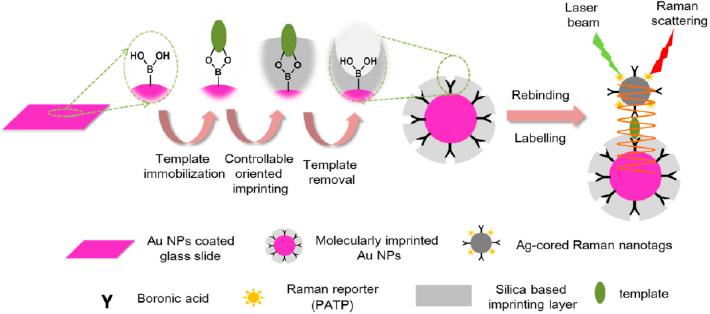
Figure 3. Preparation method and principle of plasma immuno-sandwich assay of bis-borate affinity nanoparticles [48].